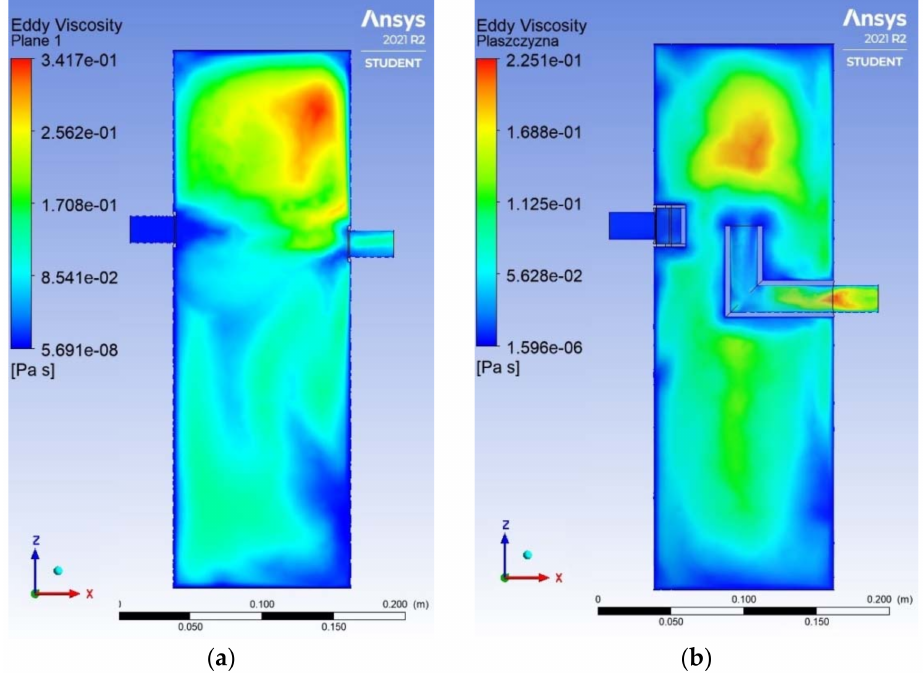
Figure 9. Swirls occurring in the turbulent flow in the axis at the set velocity v 5 for: ( a ) OS, ( b )